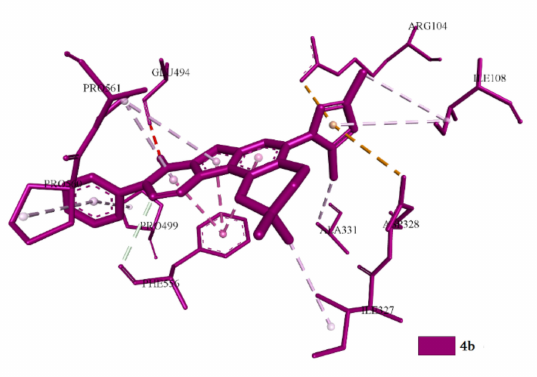
Figure 8. Superstation of 4b in the central site of the active center of SERT.